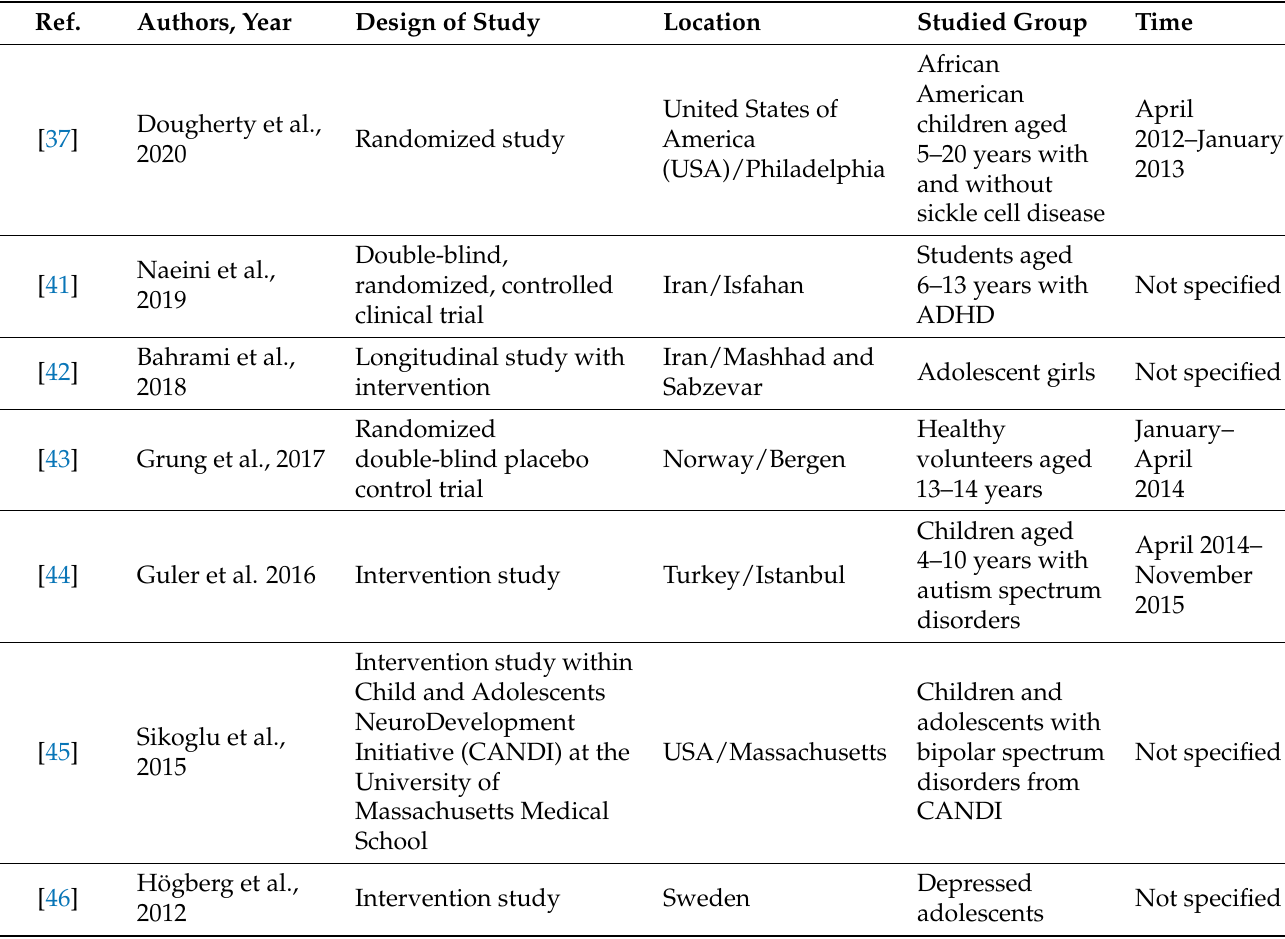
Table 2. The basic characteristics of the included intervention studies, including study design, location, studied group and time.